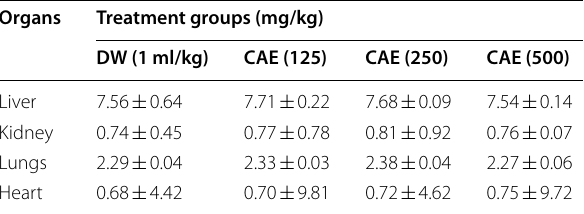
Table 1 Relative organ weight of rats following 28-day repeated administration of Culcasia angolensis leaves extract (CAE) Organs